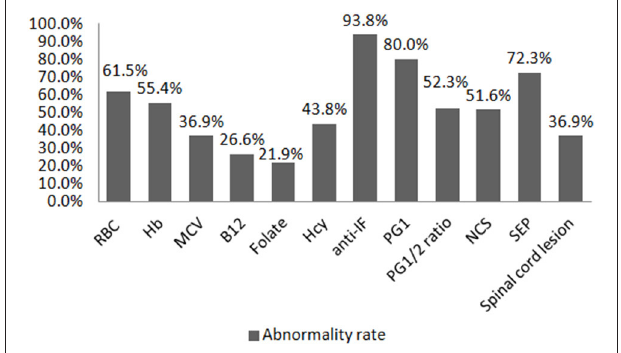
FIGURE 1 | Abnormality rate of different auxiliary examinations. RBC, red blood cell; Hb, hemoglobin; MCV, mean corpuscular volume; B12, vitamin B12; Hcy, homocysteine; anti-IF, antibody to the intrinsic factor; PG1, pepsinogen 1; PG1/2, pepsinogen 1/pepsinogen 2; NCS, nerve conduction study; SEP, somatosensory evoked potential. The abnormality rates of B12 and folate only refer to the rates of decreased value in this figure.